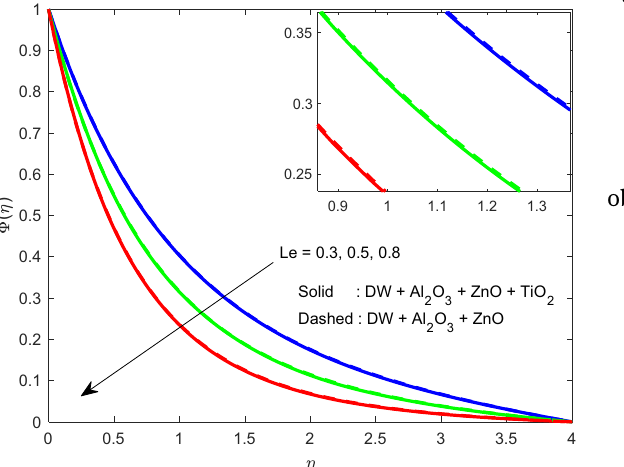
Figure 13: Increasing e ff ects of P e on χ ( η )